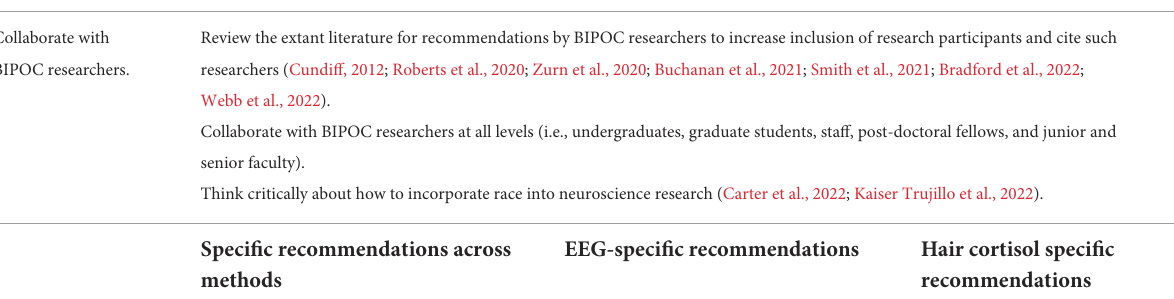
TABLE 1 Recommendations for researchers to improve inclusive practices in EEG and hair cortisol research. Recommended broad